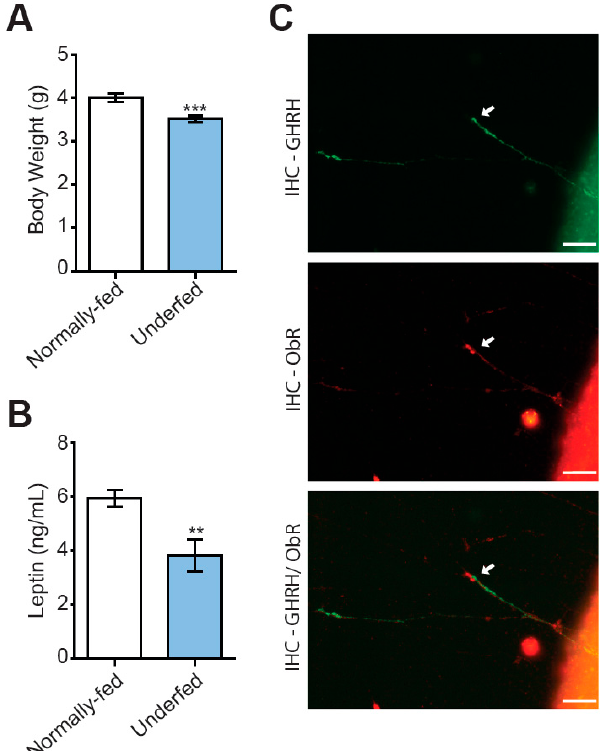
Figure 1. Underfeeding during suckling results in lower body weight and plasma leptin levels. ( A ) Increases in litter size from six (normally fed, open bars) to nine (underfed, blue bars) pups per dam are associated with a lower body weight in pups, by the age of seven days ( n = 32 normally fed pups and 41 underfed pups of both sexes). ( B ) Underfeeding during suckling was associated with lower plasma levels of leptin at 10 days of age, as determined by ELISA ( n = 8 per group). ( C ) Il- lustration (40X magnification obtained with a BX43 Olympus fluorescence microscope equipped with a DP73 CCD camera) of a growing axon from an arcuate nucleus explant cultured in vitro, showing that the GHRH+ axon in green (uppermost image) expresses the leptin receptor in red (middle image). A merged image is shown at the bottom (arrow). Scale bars represent 20 µm. Data are presented as the mean ± SEM. Comparisons were performed in Mann–Whitney tests, with ** p < 0.01 and *** p < 0.001. We investigated the possibility that leptin might stimulate the development of GHRH neurons directly, by determining whether growing GHRH axons expressed the leptin receptor (Ob-R) in the Ghrh-eGFP mouse model [19,30], in which the identification of axons from GHRH neurons is simple. We confirmed, in our arcuate nuclei explants micro-dissected from seven-day-old normally fed Ghrh-eGFP pups and cultured in vitro, that growing axons of GHRH neurons expressed the leptin receptor (Figure 1C). More- over, the distal part of growing GHRH+ axons and the growth cone of these axons ap- peared to be enriched in the leptin receptor, consistent with a potential role of leptin signaling in the axon growth of GHRH neurons. 3.1. Leptin Stimulates Axon Growth in GHRH Neurons in Arcuate Nucleus Explants from Normally Fed Pups We then investigated whether leptin could regulate axon growth in arcuate neurons, using arcuate nucleus explants harvested from seven-day-old normally fed pups. Leptin